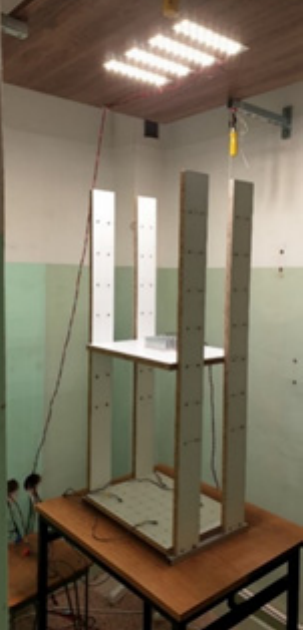
Figure 3. View of the test set ‐ up with external lighting.